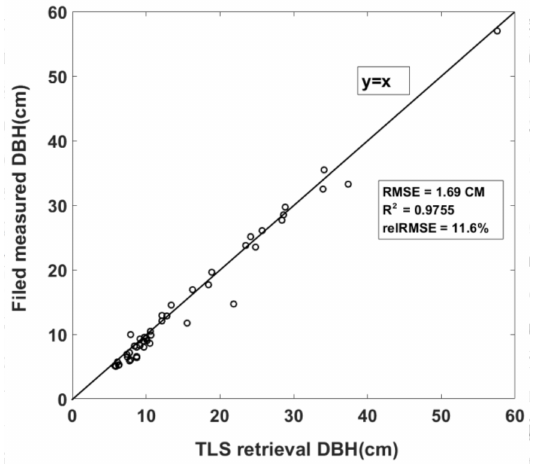
Figure 11. Scatter plot for terrestrial laser scanning (TLS) estimated versus field measured DBH, in the best accuracy condition of multi-scan mode of the natural secondary forest (nonlinear least square algorithm, a height bin of 0.24 m, and a gray scale threshold of